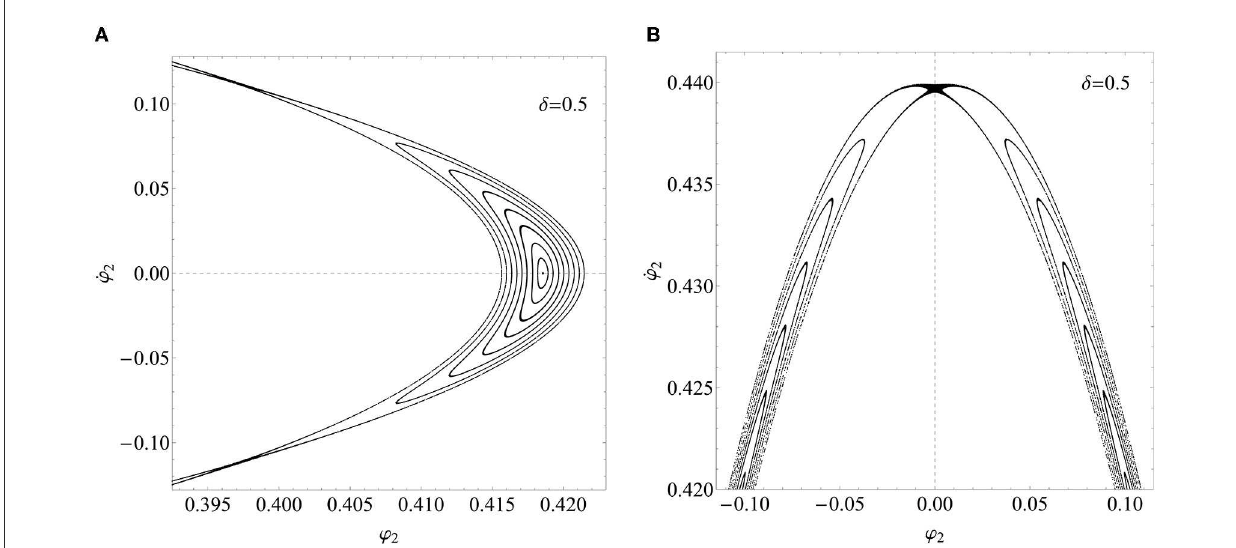
FIGURE9 View enlargement of the Poincaré map for the solutions at δ = 0.5. In (A) , one of the 10 islands, namely, that symmetric to the axis ˙ ϕ 2 = 0, for positive ϕ 2 , is shown. The elliptic point, two hyperbolic points formed by the stable and unstable manifold bounding the island, and a number of 10-periodic tori are visible. In (B) , the hyperbolic point on the axis ϕ 2 = 0 for positive ˙ ϕ 2 is shown (there is a symmetric one for negative ˙ ϕ 2